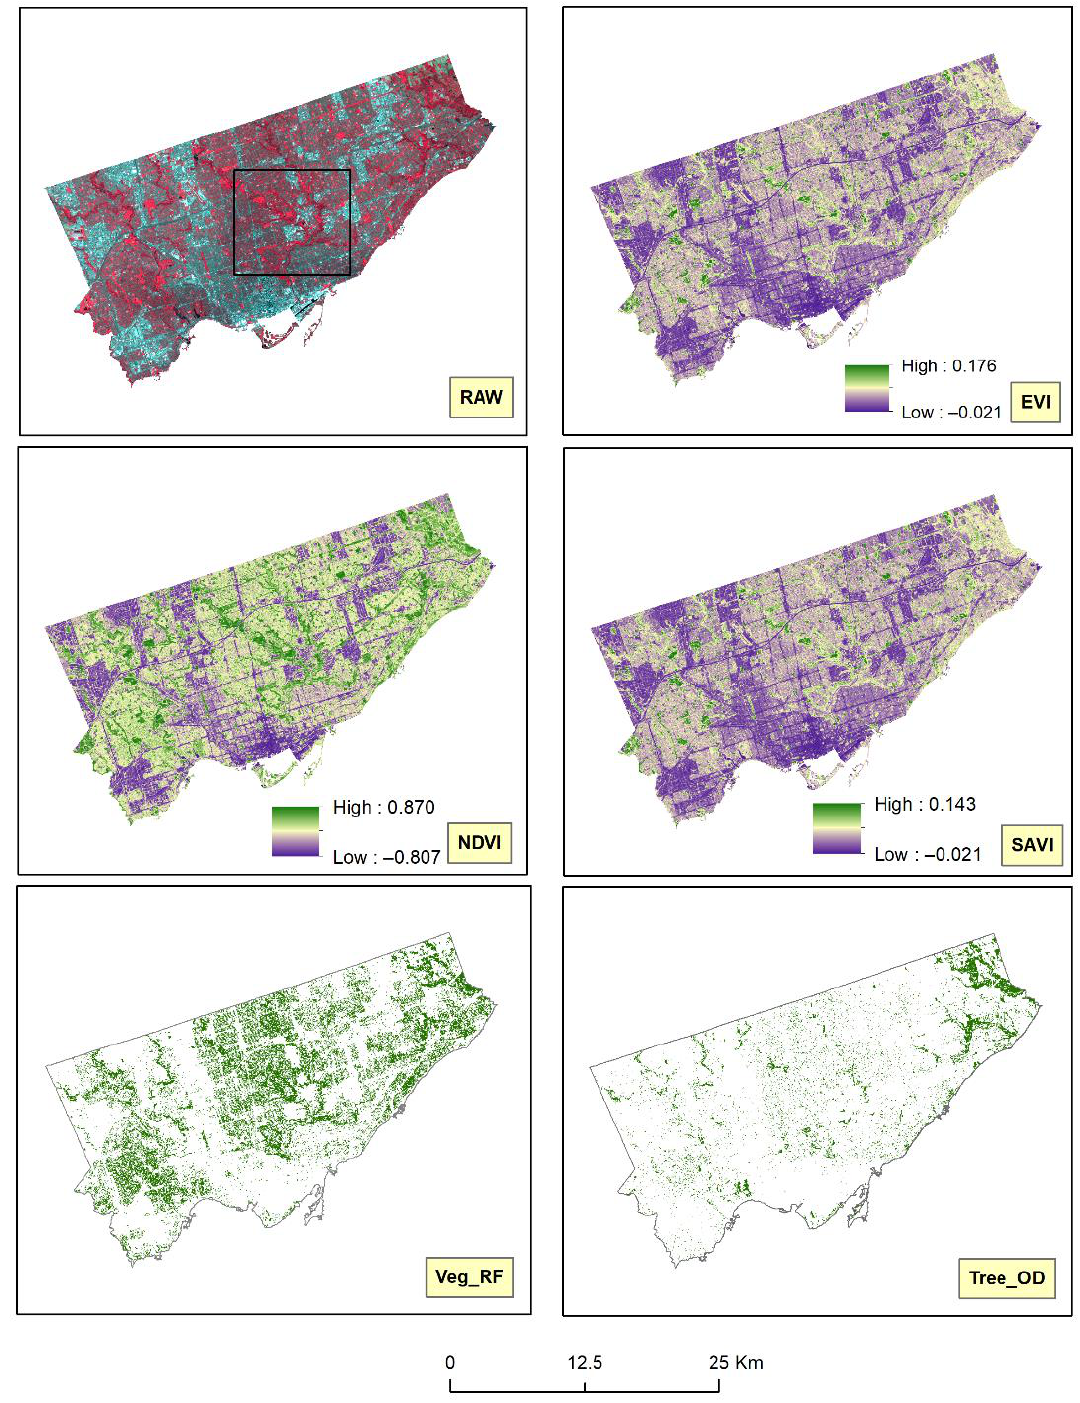
Figure 2. The macro-scale differences between the three vegetation indices and the area-based measures of vegetation cover. The shades of green represent the vegetation-covered areas for all the three vegetation indices, and the solid green color represents vegetation cover in the area-based measures. The black selection box in the raw image represents the portion of the study area that was zoomed-in in Figure 3 for better visualization of the micro-scale